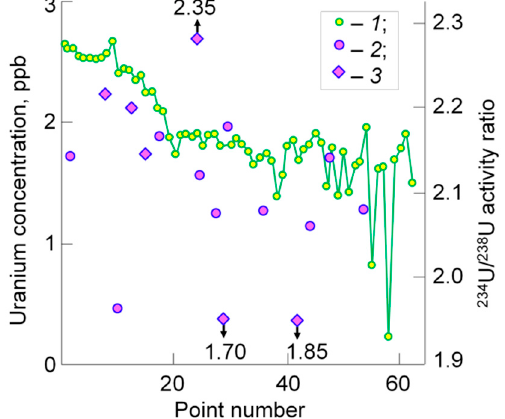
Figure 4. The content and isotopic composition of uranium in the Selenga River (the profile length is approximately 400 km, point 1 is on the border with Mongolia, and point 60 is at the mouth) and its tributaries (adapted from [84]): 1 —uranium concentration in water of Selenga River; 2 , 3 —isotopic composition of uranium in water of Selenga River and its tributaries, respectively.